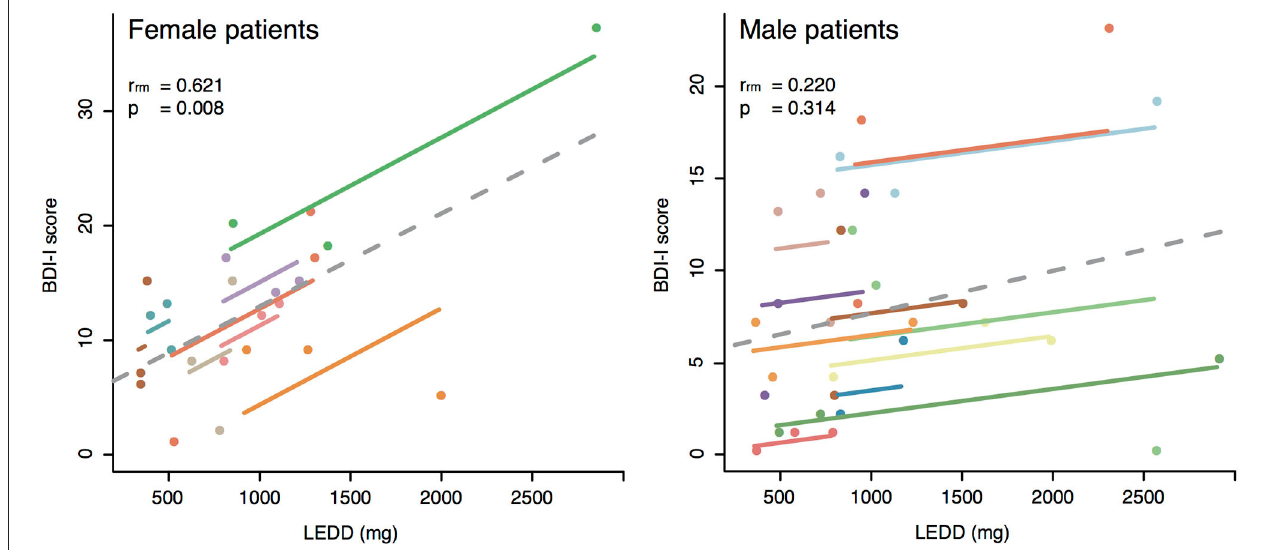
FIGURE 3 | Repeated measures correlations. The left panel represents BDI-I scores vs. LEDD (mg) for female PD patients. The right panel represents BDI-I scores vs. LEDD (mg) for male PD patients. Color coded are the single patients at the three planned stages. The separate parallel lines show the rmcorr fit for each individual patient. The sign of the rmcorr coefficient (i.e., positive or negative) is indicated by the direction of the common regression slope plotted as dotted line. Inset values give the statistics for the corresponding repeated measures correlation.